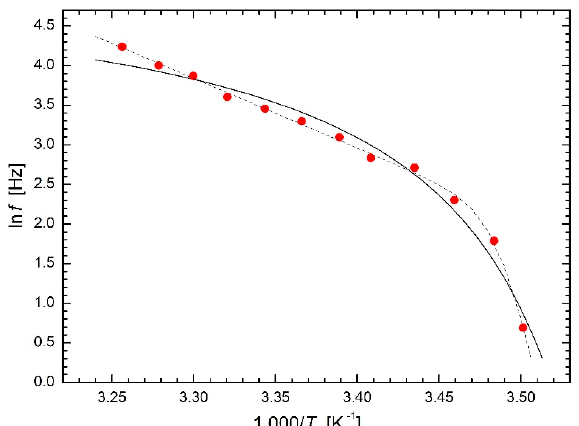
Figure 14. Modified Arrhenius plots for the rate of terrapin’s heartbeat [4,31] based on Equation (23) (solid line) compared with the fit using Equations (16) and (17) as regression function (dashed line).